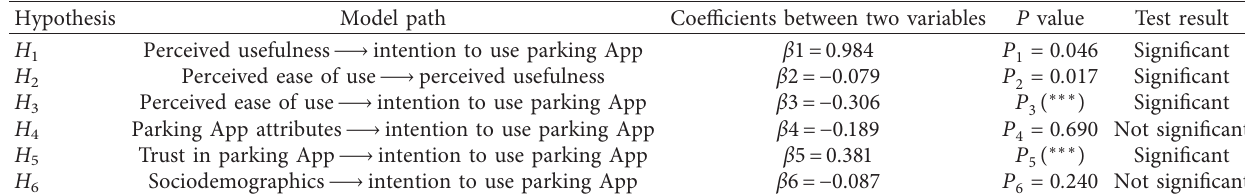
Table 4: Hypothesis testing results.